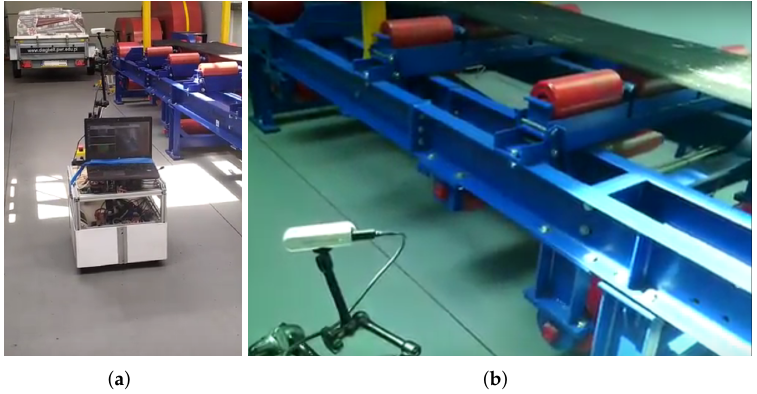
Figure 13. An inspection robot during the experiment: ( a ) general photo; ( b ) zoom on sensor.